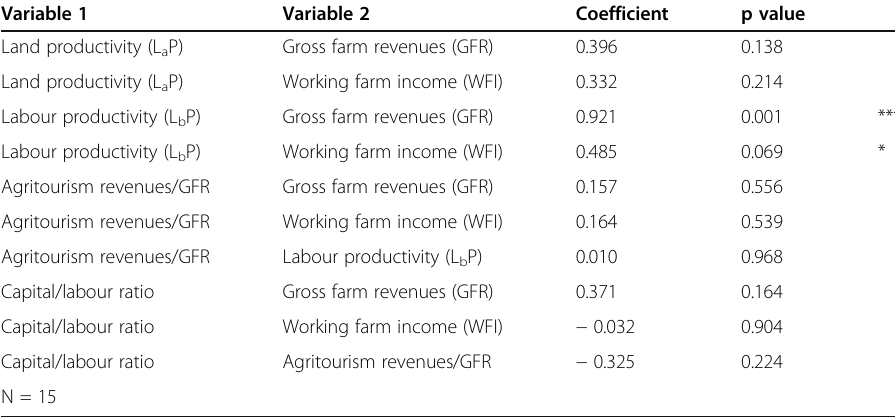
Table 6 Spearman ’ s rank correlations among diagnostic variables and some balance sheet analysis